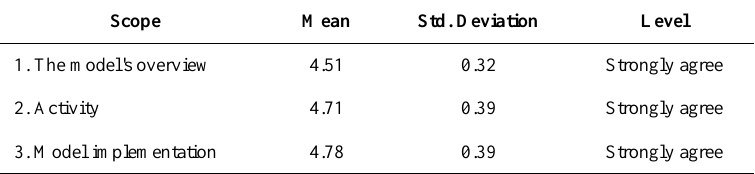
Table 3. The suitability of the training model from experts’ assessment with the focus group technique